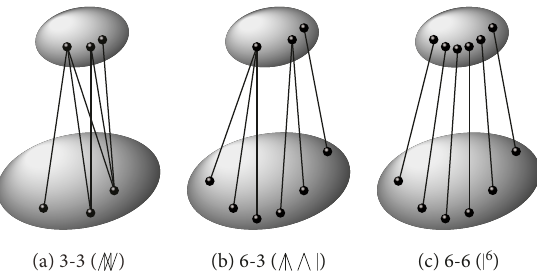
Figure 2: Examples of combinatorial classes of 𝑛 - 𝑚